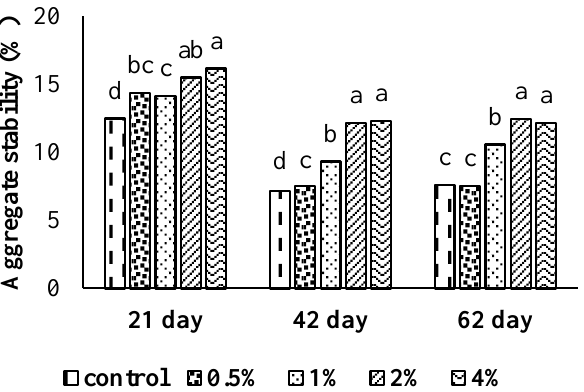
Figure 3. Effects of different rates of HA applications on soil